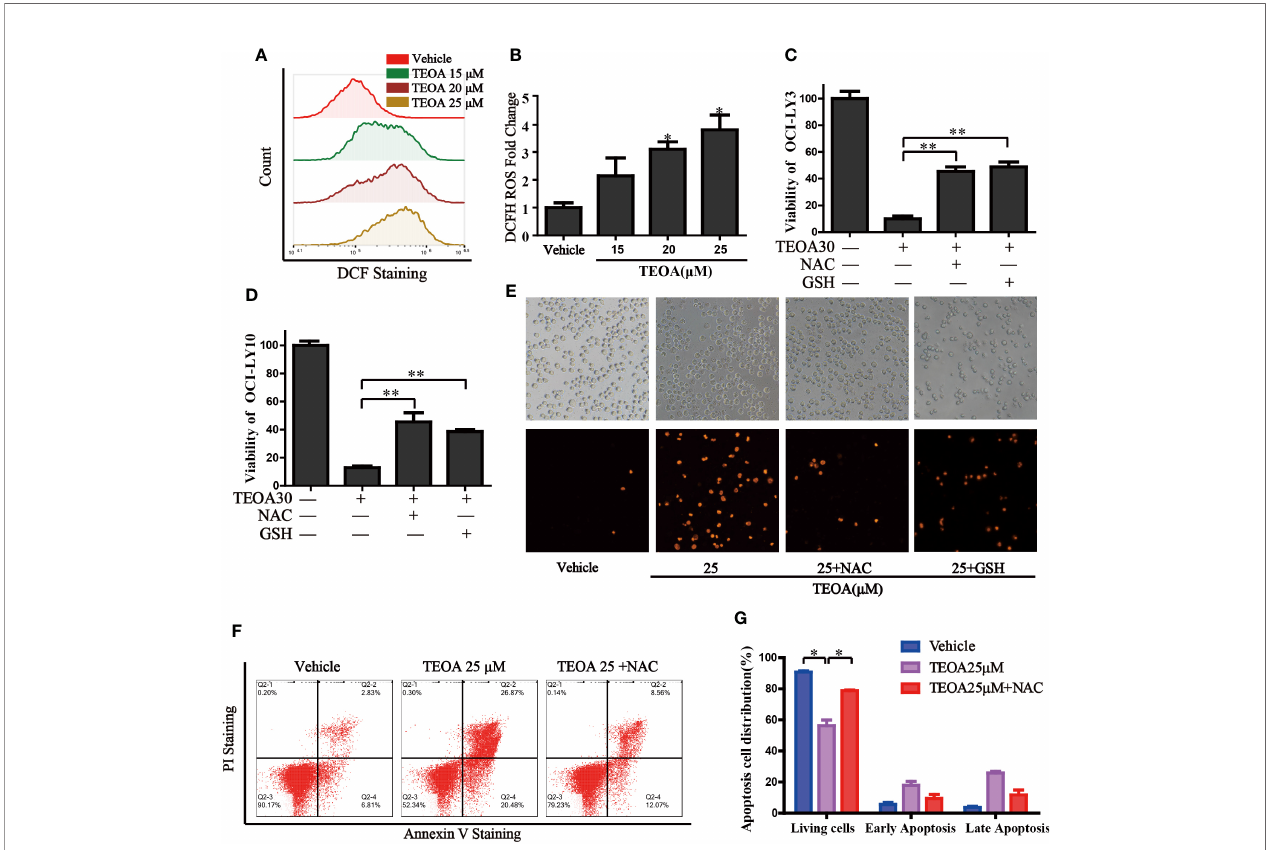
FIGURE 4 | TEOA increased the production of cellular ROS and promoted apoptosis. (A) OCI-LY10 cells were exposed to different concentrations of TEOA for 12 h, then treated cells were stained with DCF-DA for 30 min, cellular ROS levels were determined by fl ow cytometry. (B) Quantitative analysis of the cellular ROS, * P <0.05. (C, D) OCI-LY10 and OCI-LY3 cells were treated with TEOA for 12 h in the presence or absence of NAC and GSH, cell viability was determined by CCK8 assay and PI staining (E) . (F) Flow cytometry was used to detect apoptosis in DLBCL cells exposed to TEOA with or without NAC treatment. (G) The proportion of apoptotic cells was shown on the right, * P <0.05, ** P